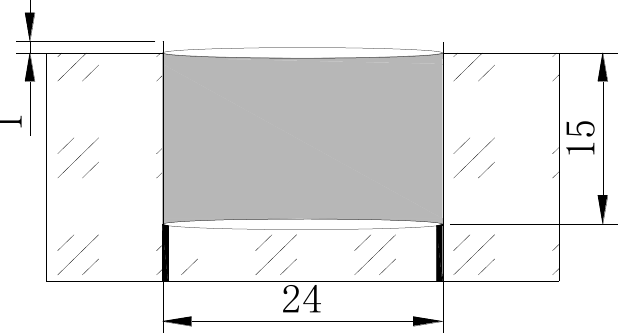
Figure 2. Sketch map of a trap in the field site. The unit is cm.